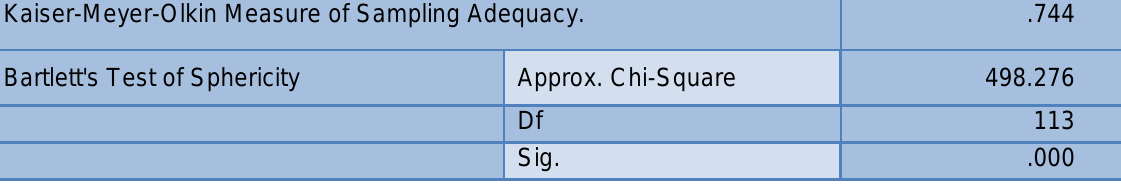
Table 1 KMO and Bar tlett’s Test